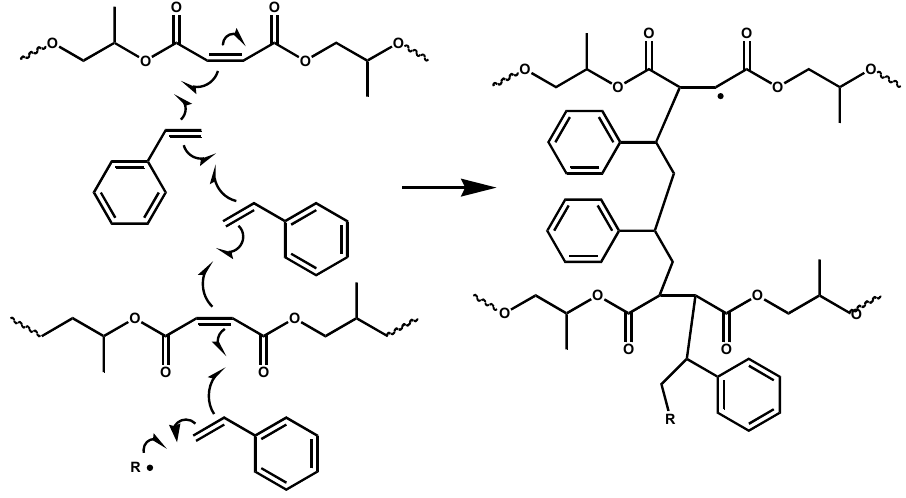
Scheme 1. An early stage in the crosslinking of an unsaturated polyester (UP), based on the condensation of maleic anhydride and phthalic anhydride with propylene glycol, via a free-radical chain reaction of the maleate double bonds in the UP with styrene. R• represents a primary radical arising from the decomposition of the free-radical initiator (in this work, MEK peroxide). Note that phthalate units are not involved in the crosslinking reaction and therefore are not shown in the interests of clarity.